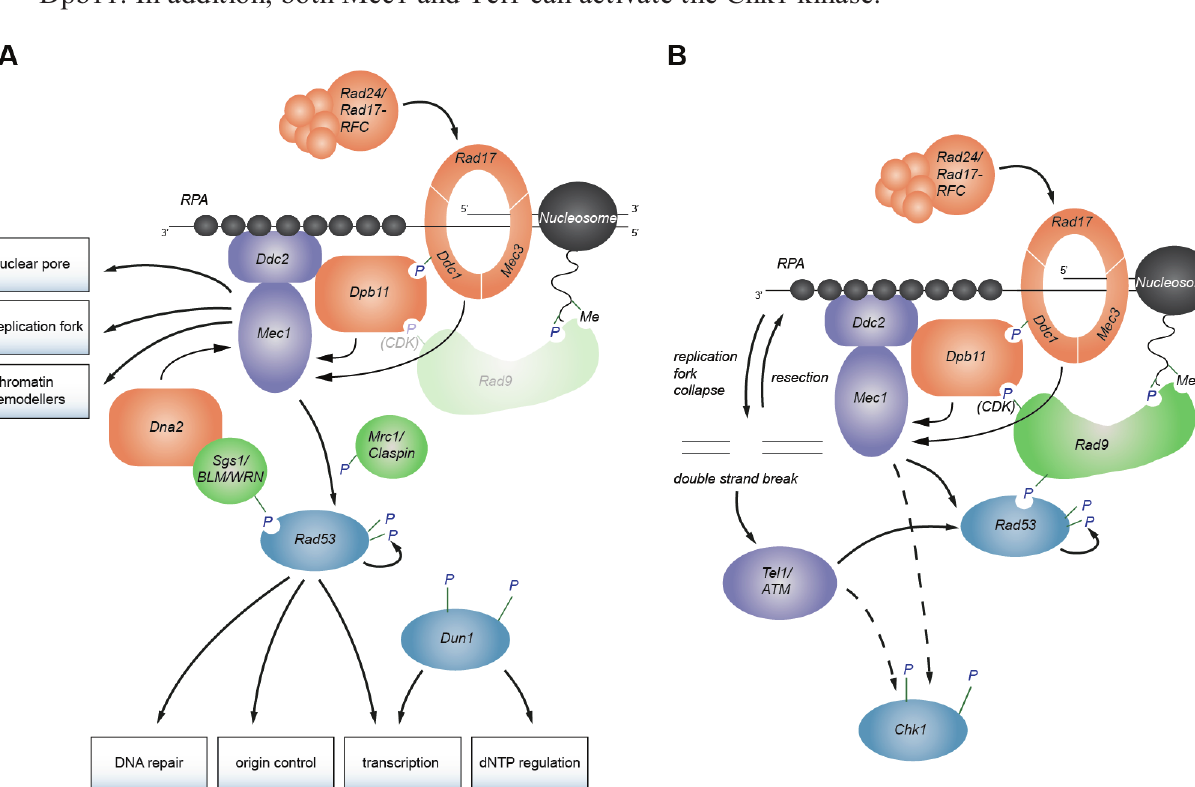
Figure 1. Checkpoint signaling network. ( A ) Replication checkpoint signaling. The yeast equivalent to ATRIP, Ddc2, binds ssDNA that is covered with RPA, while the 9-1-1 checkpoint clamp is loaded onto ds/ssDNA junctions. Dpb11, 9-1-1, and Dna2 (checkpoint sensors, orange) can activate Ddc2-Mec1 (checkpoint kinase, purple). Checkpoint mediators like Mrc1 and Sgs1 (green) help activate Rad53 (checkpoint transducing kinase, blue). Rad53 activates Dun1 and other downstream responses. ( B ) DNA damage checkpoint signaling. Crosstalk between Mec1 and Tel1 (DSB response) can occur, if stalled replication forks collapse, since they can generate DSBs. These are resected to generate ssDNA which activates Mec1. Rad9, the DNA damage checkpoint mediator, can be recruited by histone modifications and also binds, once phosphorylated by CDK, to Dpb11. In addition, both Mec1 and Tel1 can activate the Chk1